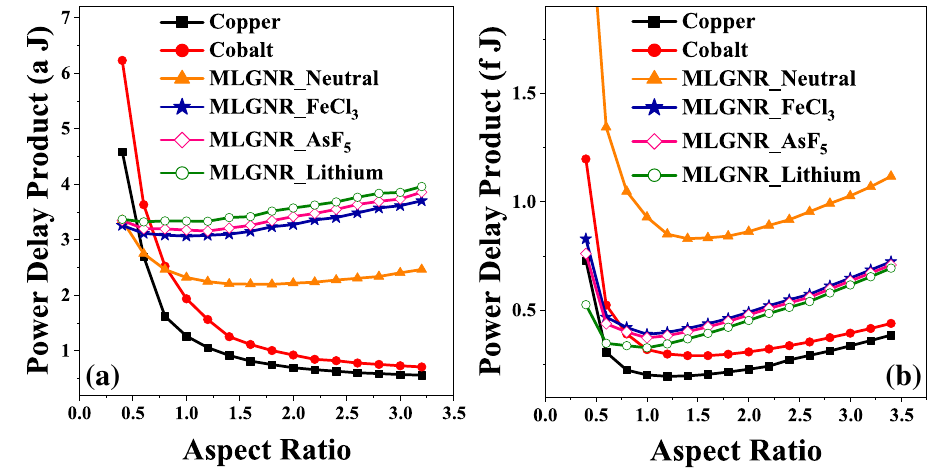
Figure 7. Optimized AR at minimum power delay product in ( a ) intermediate level (L = 10 µ m) and ( b ) global level (L = 1 mm) interconnects.